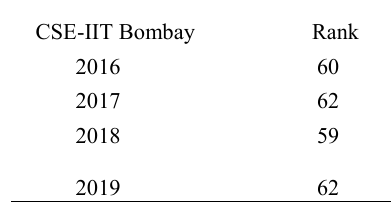
Figure 6. Predicted ranks for